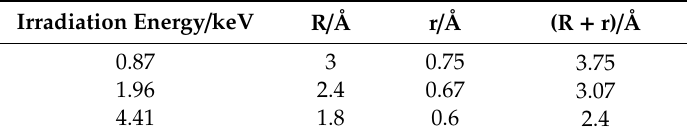
Figure 4. The correlation between effective range and irradiation density. Table 1. Calculated value of r and R.